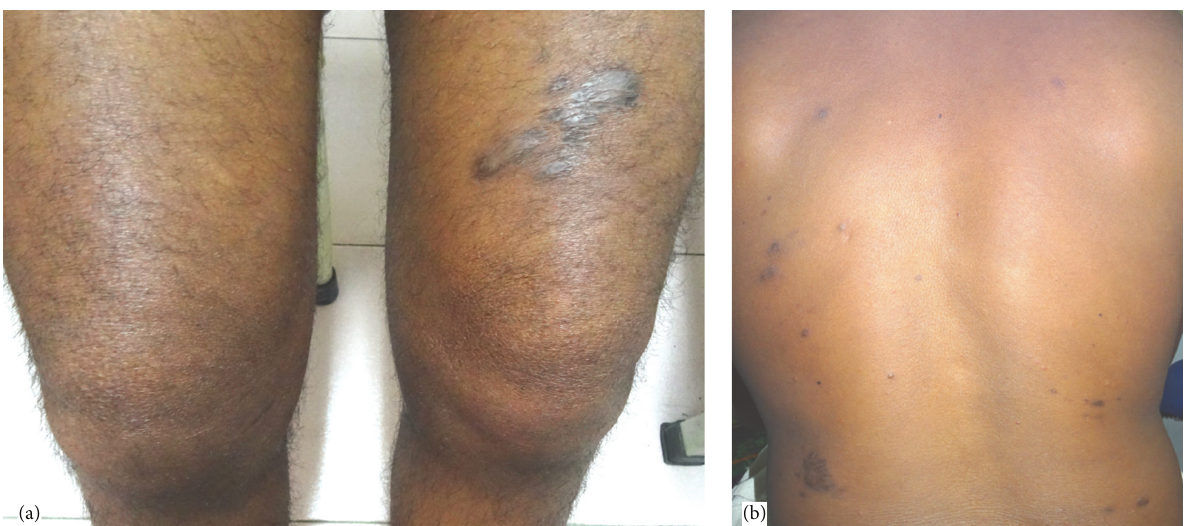
Figure 4: (a) Lesion shown in Figure 2(a) after 1-year treatment of leprosy. (b) Lesion shown in Figure 2(b) after 1-year treatment of